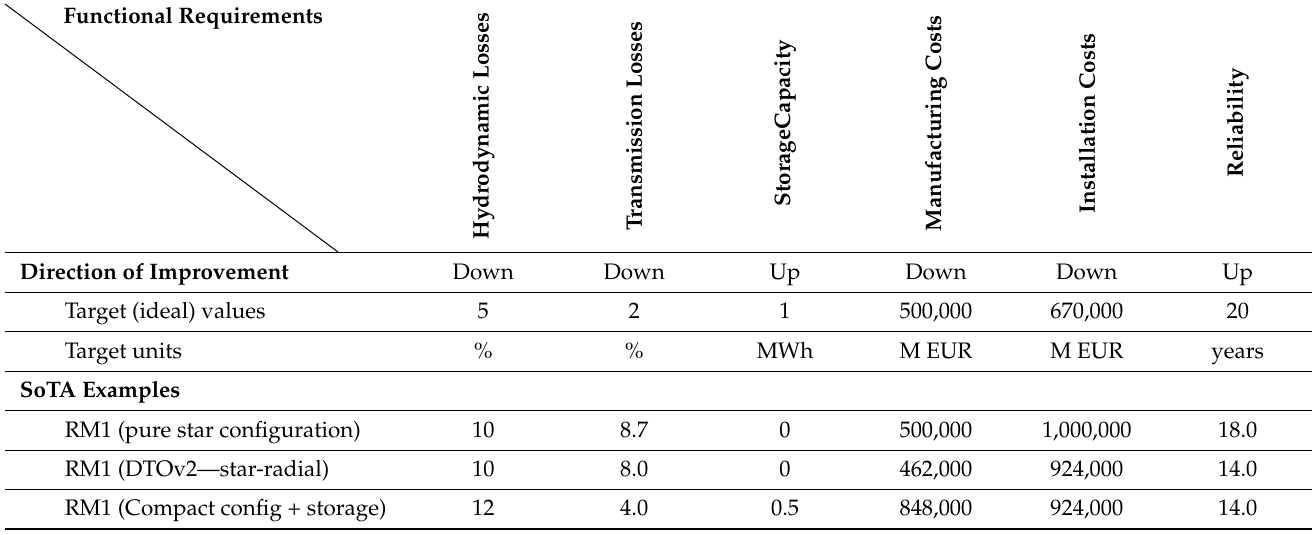
Table 9. Example showing how the target (ideal) values compare to the state-of-the-art (SoTA) for each functional require- ment for the tidal energy array improvement